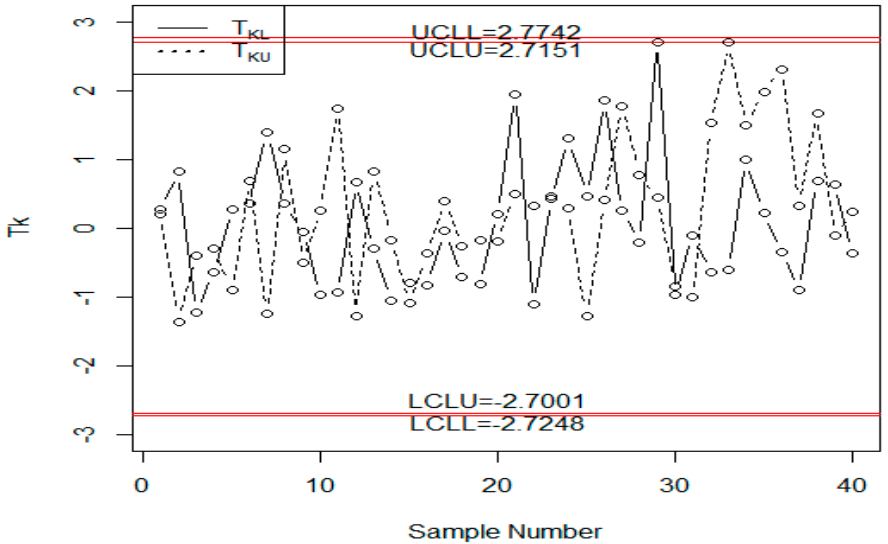
Processes 2019 , 7 , 742 10 of 15